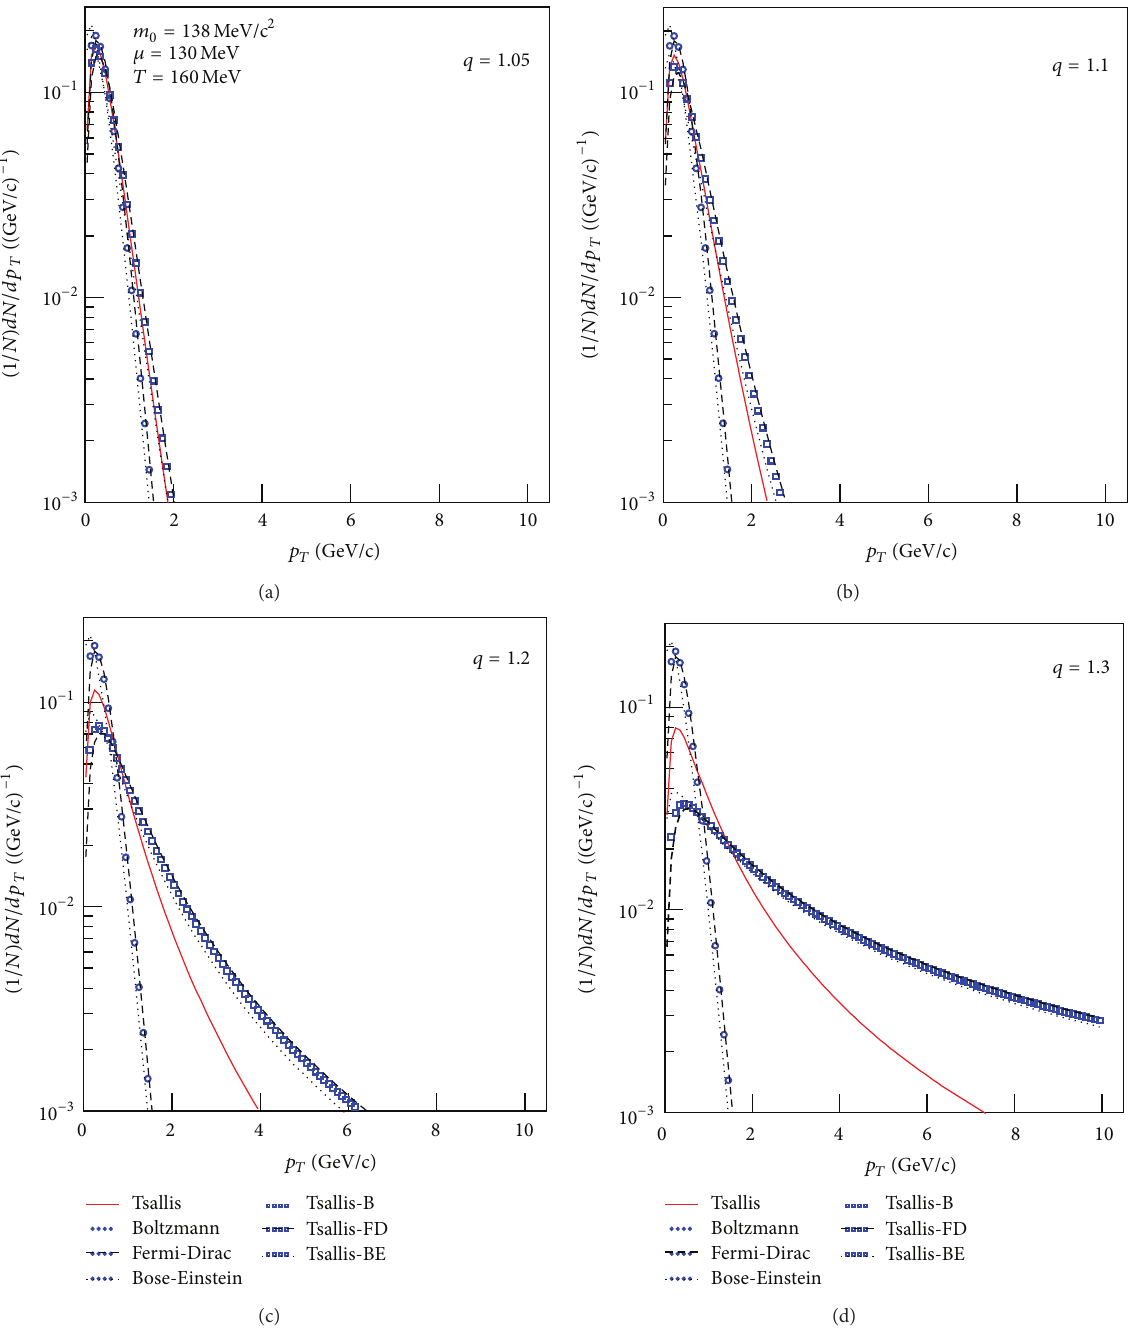
Figure 1: Transverse momentum spectra described by several distributions for 𝑚 0 = 138 MeV/c, 𝜇 = 130 MeV, 𝑇 = 160 MeV, and 𝑞 = 1.05 (a), 1.1 (b), 1.2 (c), and 1.3 (d), respectively. The solid curves, open circles, dashed and dotted curves which neared the open circles, open squares, and dashed and dotted curves which neared the open squares correspond to the Tsallis, Boltzmann, Fermi-Dirac, Bose-Einstein, Tsallis-B, Tsallis-FD, and Tsallis-BE distributions,